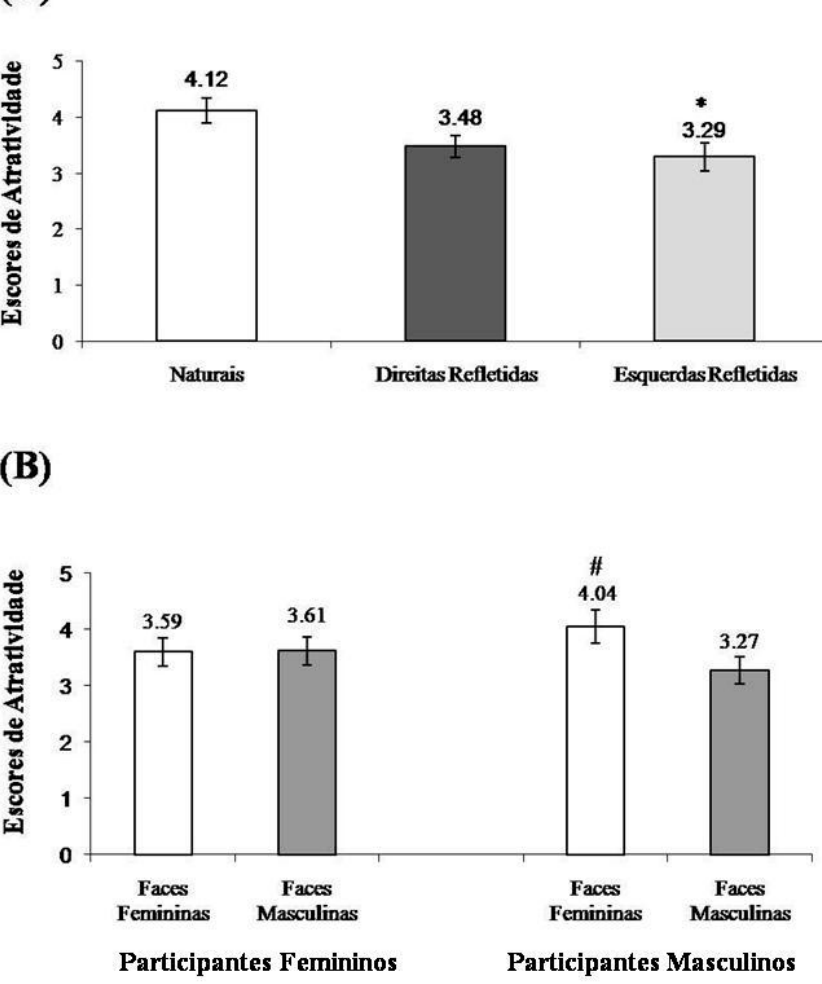
Figura 2 . Experimento II – Faces Com Componentes Internos Nota . Experimento II – Atratividades das faces somente com os componentes internos. (A) Efeito das condições de manipulação de simetria das faces. (B) Interação entre o sexo dos participantes e o sexo das faces. Barras de erro representam ±1 erro padrão da média. (* p <0,01, comparada à média dos escores às faces naturais; # p <0,01, compara- da à média dos escores dos participantes masculinos às faces